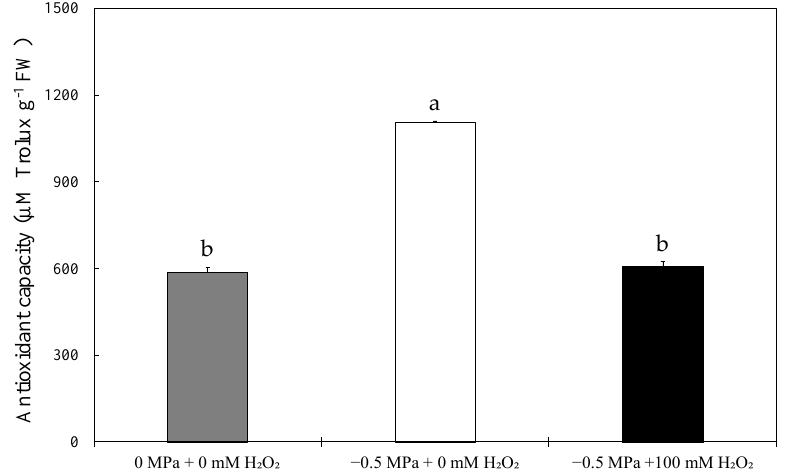
Figure 4. Effect of hydrogen peroxide treatment on the antioxidant activity of seeds at 24 h after imbibition under different water potentials. Antioxidant activity is expressed as micromoles of Trolox equivalent per gram based on the fresh weight. Seeds were imbibed with distilled water (0 MPa) without H 2 O 2 and PEG solution ( − 0.5 MPa) with or without 100 mM H 2 O 2 . Columns with the same letters are not significantly different between treatments according to Tukey’s test ( p < 0.05).